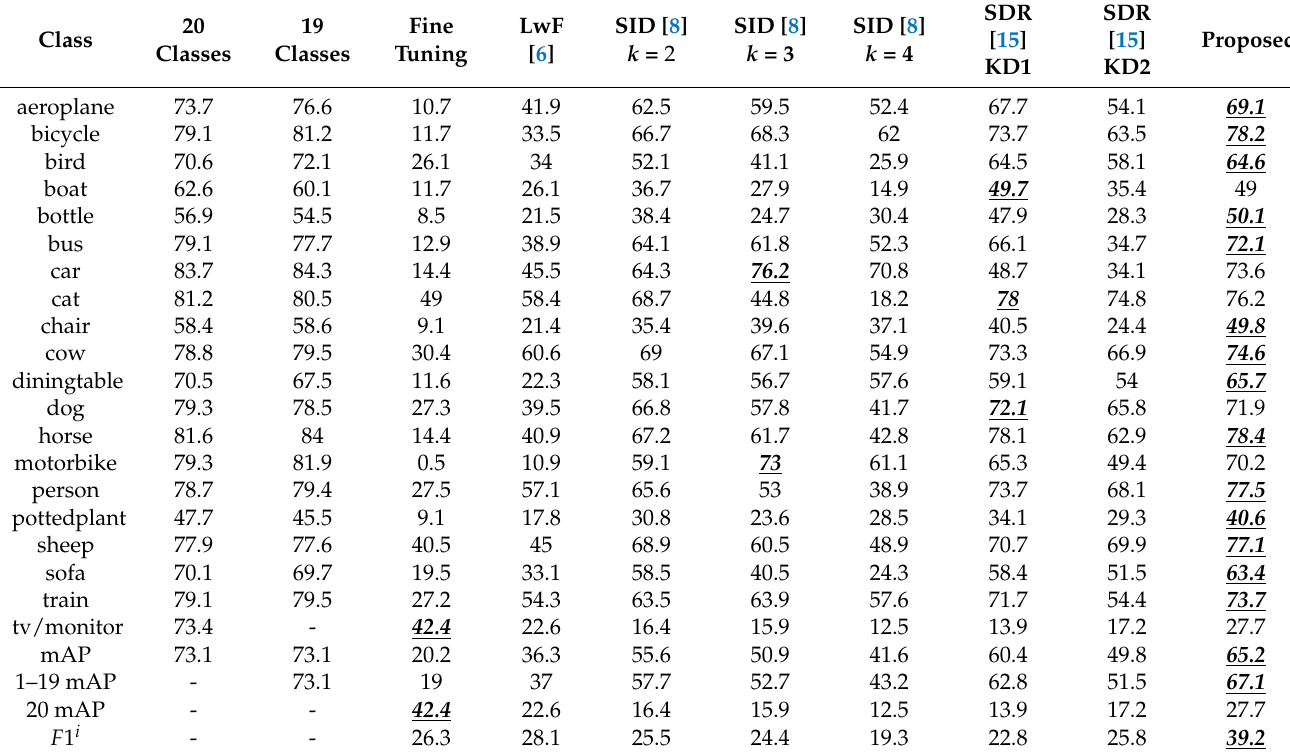
Table 1. Comparison of 19 + 1 Scenario